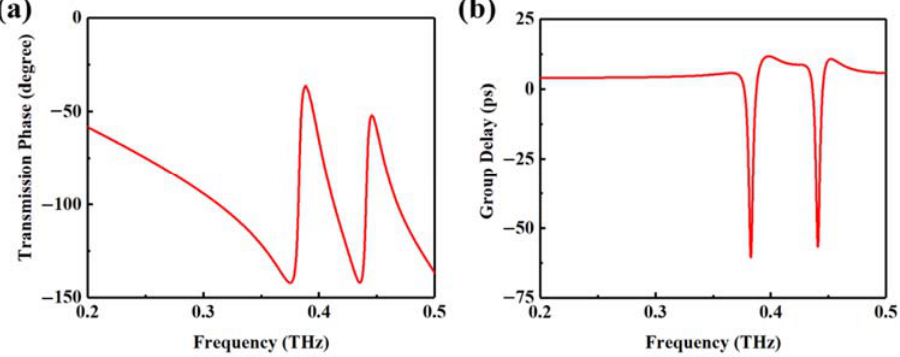
Figure 4. ( a ) Transmission phase of the proposed EIT MTM unit. ( b ) Group delay of the proposed EIT MTM extracted from the transmission curve.